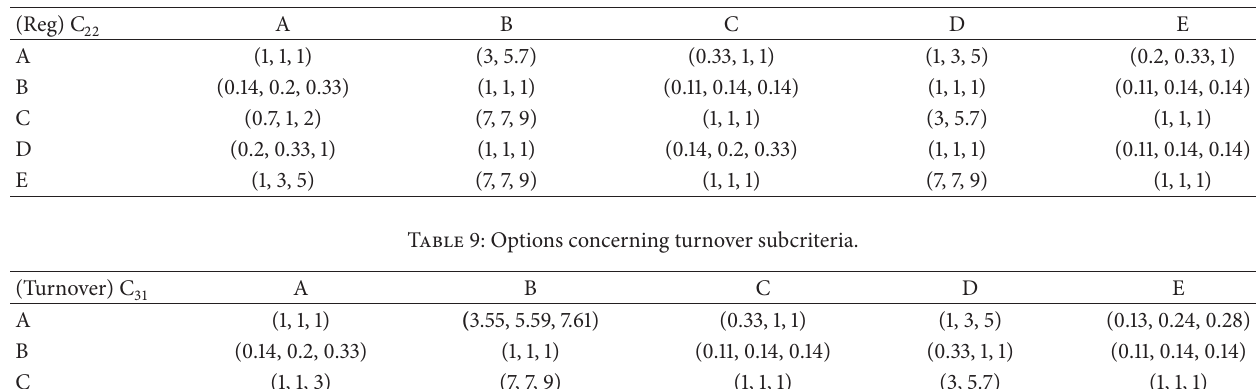
Table 8: Options concerning regulation subcriteria.